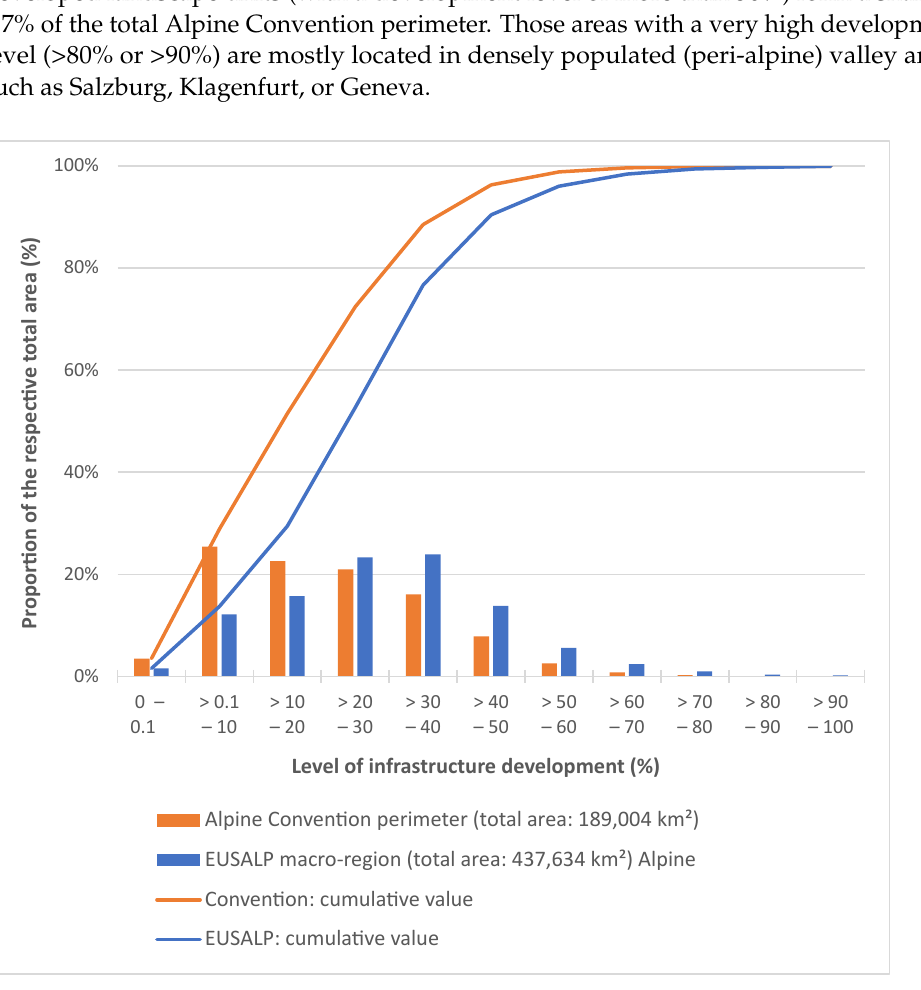
Figure 2. Level of infrastructure development, statistical comparison of Alpine Convention perimeter and EUSALP macro-region (source: authors’ figure) (Note: Area sums for AC and EUSALP differ from those in Table 1, as landscape units are also included that are only partially located in the respective perimeter (at the